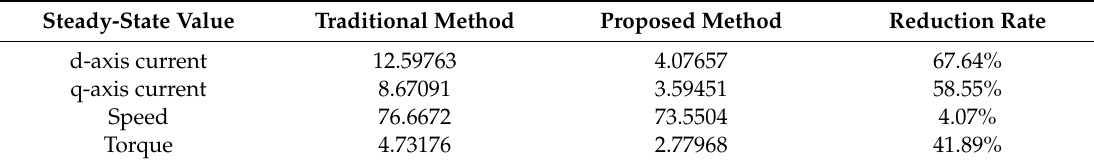
Table 3. The comparison of SD with parameter mismatches.